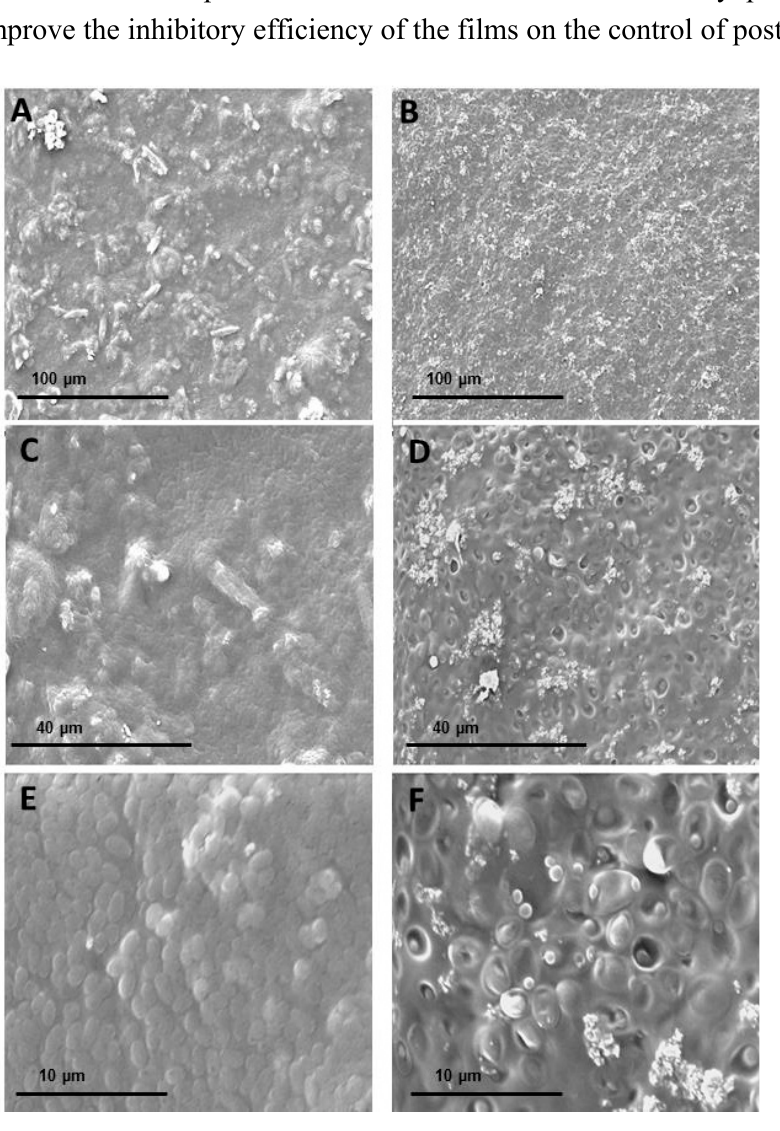
Figure 7. SEM micrographs of WEAX films ( A , C , E ) and WEAX films containing D. hansenii ( B , D , F ) at 500× magnification ( A , B ), 1500× magnification ( C , D ) and 3500× magnification ( E , F